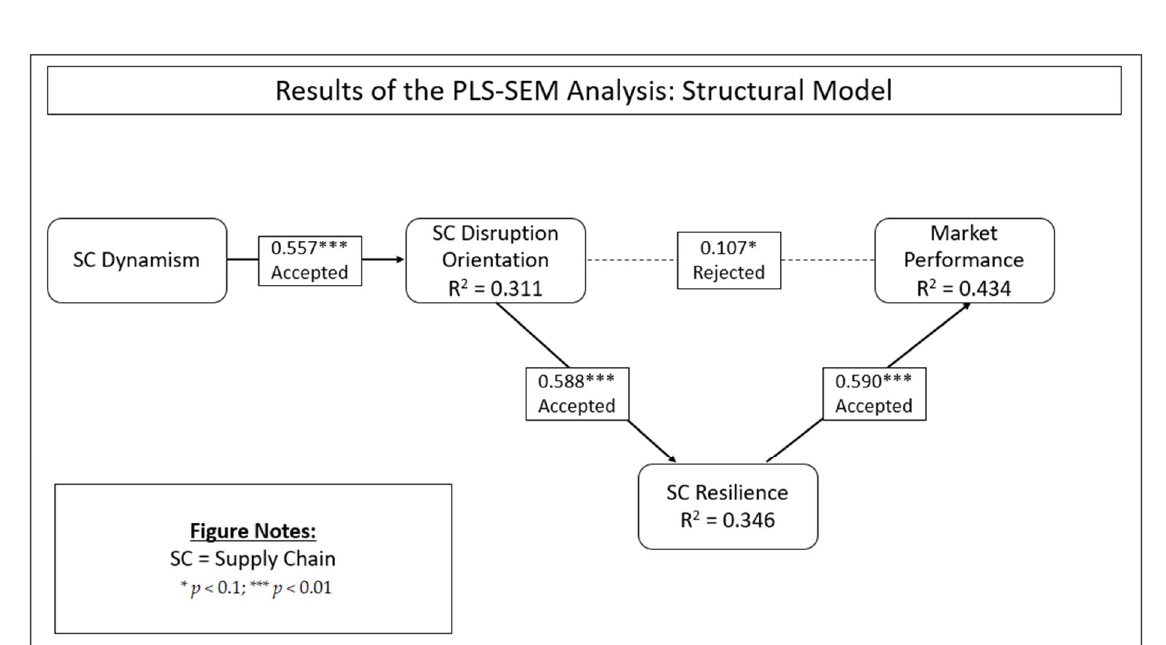
Figure 2. Results. Note: Figure 2 illustrates the pathway coefficients and the coefficients of deter- mination for the variables of the research model. The asterisks indicate the p -value cut-off points: * is a p -value less than 0.1, and *** is a p -value less than 0.01. The pathways indicate strong and meaningful relationships between the